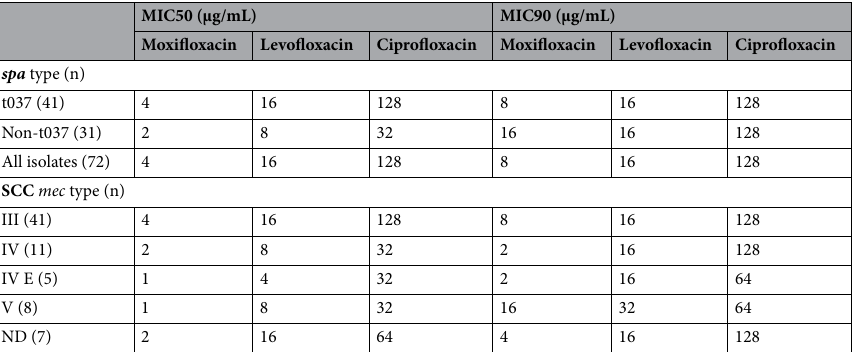
Table 2. Minimum inhibitory concentration (MIC) 50 and 90 of moxifloxacin, levofloxacin and ciprofloxacin against the major spa and SCC mec types represented in the isolates.